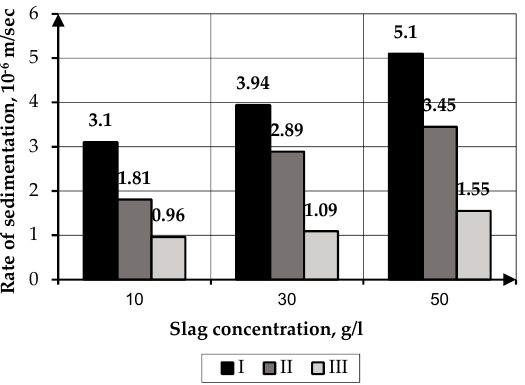
Figure 14. The dependence of the particle sedimentation rate on slag concentration in water-polymer dispersed medium after ultrasonic processing. Table 14. Comparative analysis of the sedimentation rates of slag particles in a water-polymer suspension after and without ultrasonic processing. V without ultrasonic proc. /V after ultrasonic proc. Slag Concentration, g/L